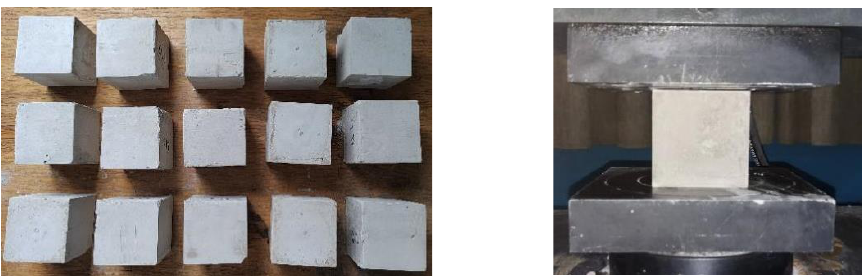
Figure 2. Standard stone powder hardened body specimens and compressive strength test.